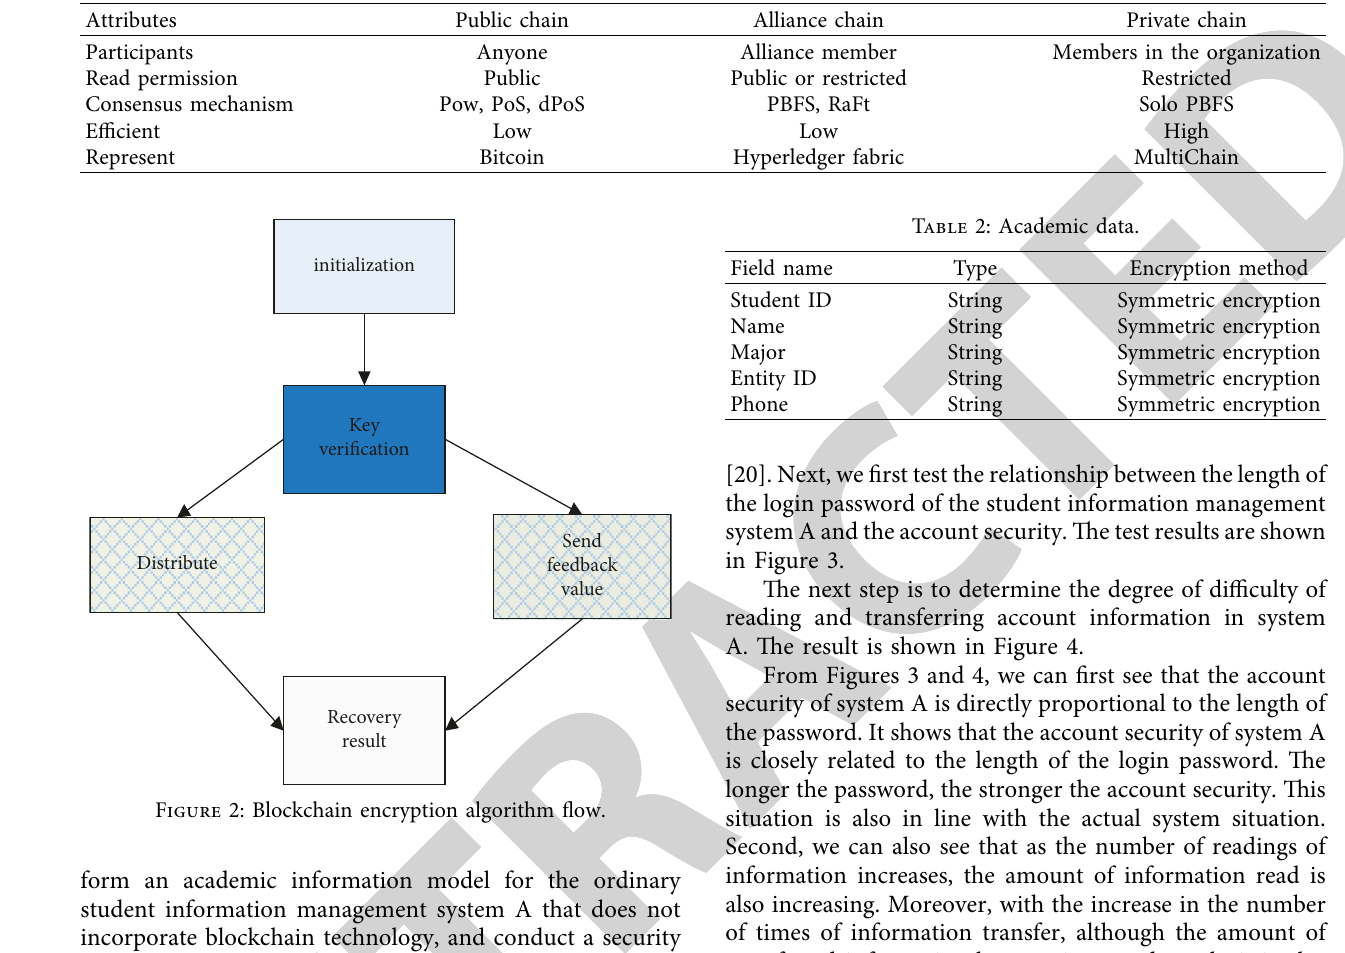
Table 1: Blockchain classification.